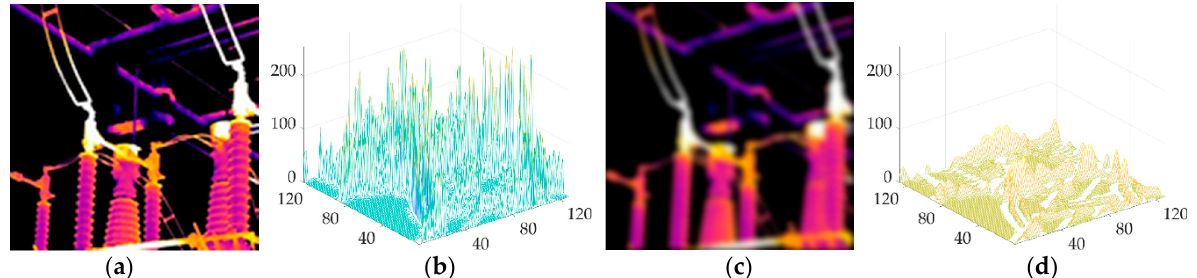
Figure 2. Schematic diagram of gradient changes before and after the infrared image is blurred: ( a ) clear infrared image; ( b ) absolute value of the row direction gradient of the clear infrared image; ( c ) blurred infrared image; ( d ) absolute value of the gradient in the row direction of the blurred infrared image.